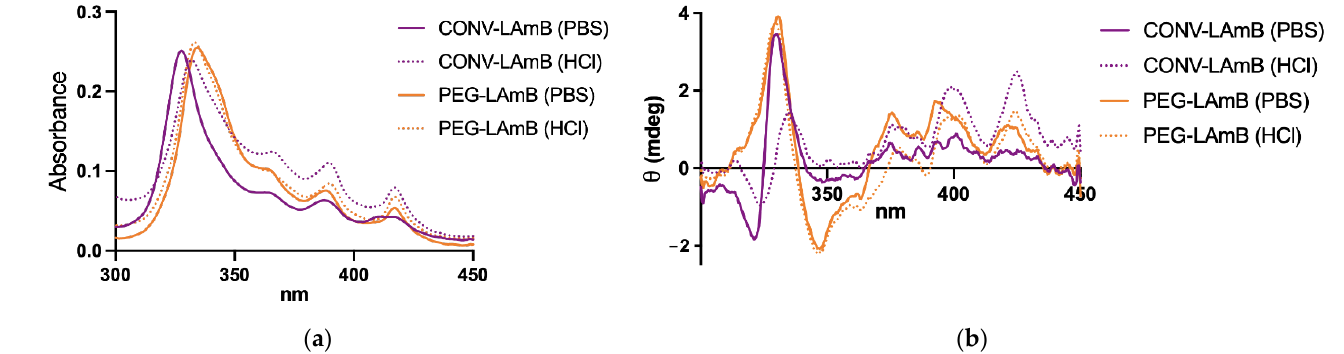
Figure 4. Absorption ( a ) and circular dichroism ( b ) spectra of AmB in PEGylated and conventional liposomal formulations, after 10-fold dilution in a medium simulating the gastric fluid or PBS and incubation for 2 h at 37 °C. Spectra were registered at 25 °C after 100-fold dilution in PBS.